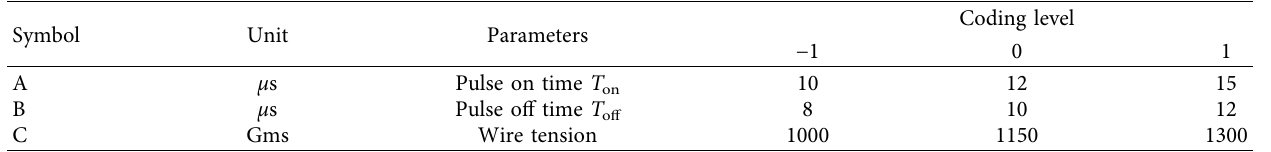
Table 1: Factors and their